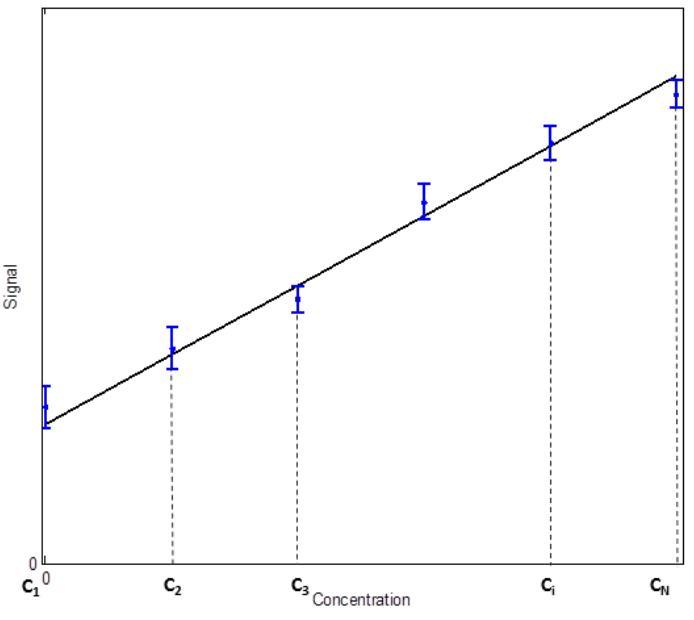
Figure 1. Calibration function.